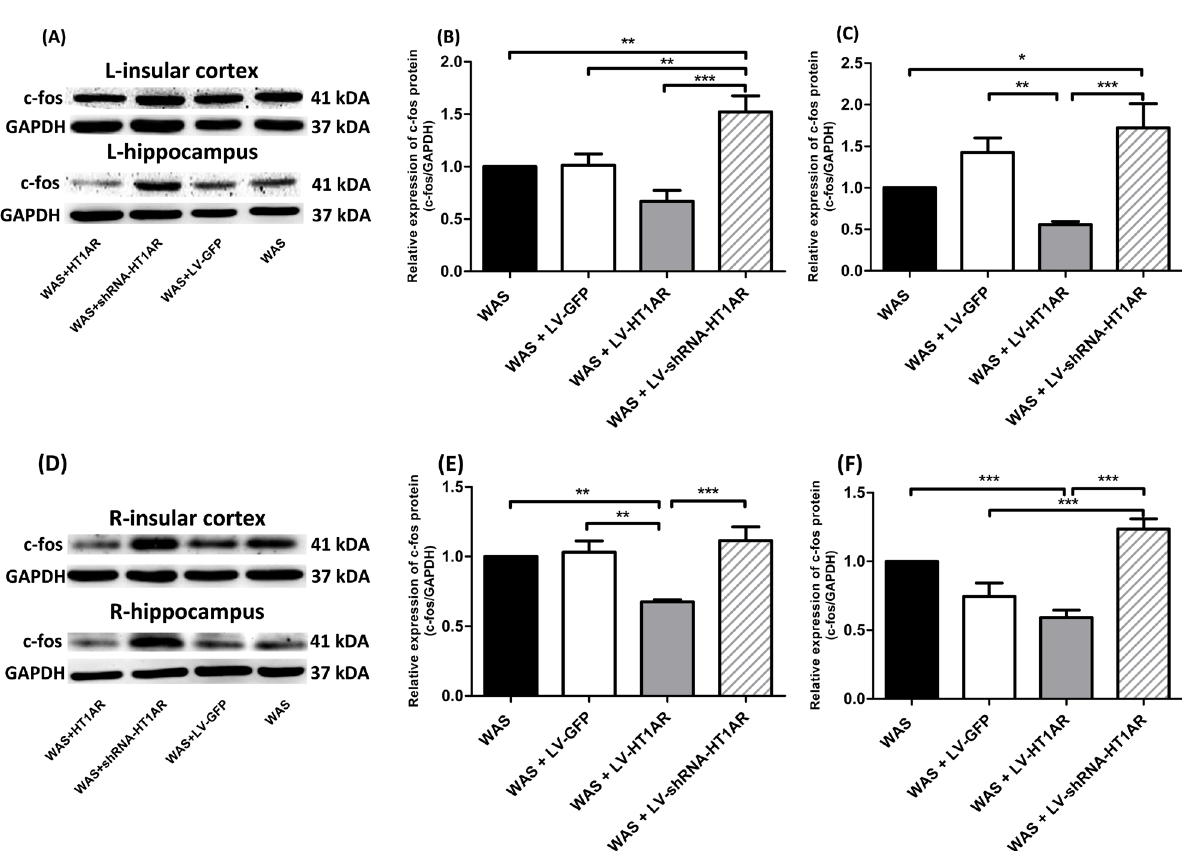
Figure 4: Effects of lentivirus intervention on expression of c-fos in the IC and hippocampus. (A) Representative immunoblots from the left IC and hippocampus. (B)(C) Protein expression levels of c-fos in the left IC and hippocampus were compared among WAS, WAS+LV-GFP, WAS+LV-HTR1A and WAS+LV-shRNA-HTR1A groups. (D) Representative immunoblots from the right IC and hippocampus. (E)(F) Protein expression levels of c-fos in the right IC and hippocampus were compared among WAS, WAS+LV-GFP, WAS+LV-HTR1A and WAS+LV-shRNA- HTR1A groups. * P<0.05, ** P<0.01, ***